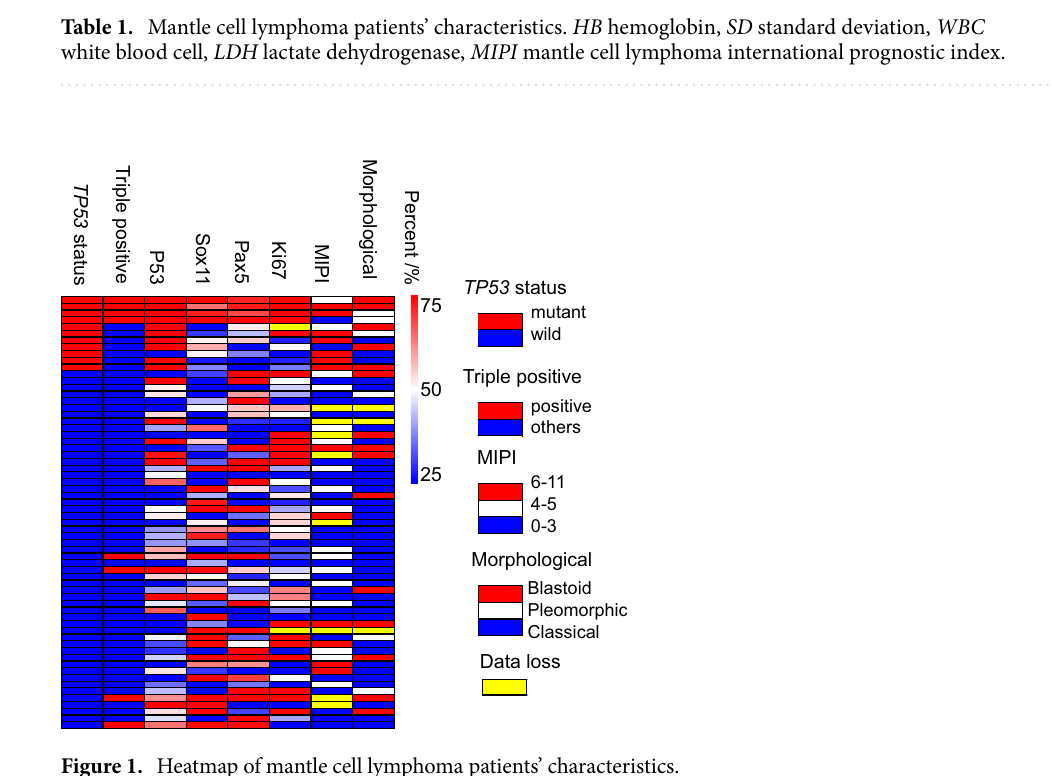
Figure 1. Heatmap of mantle cell lymphoma patients’